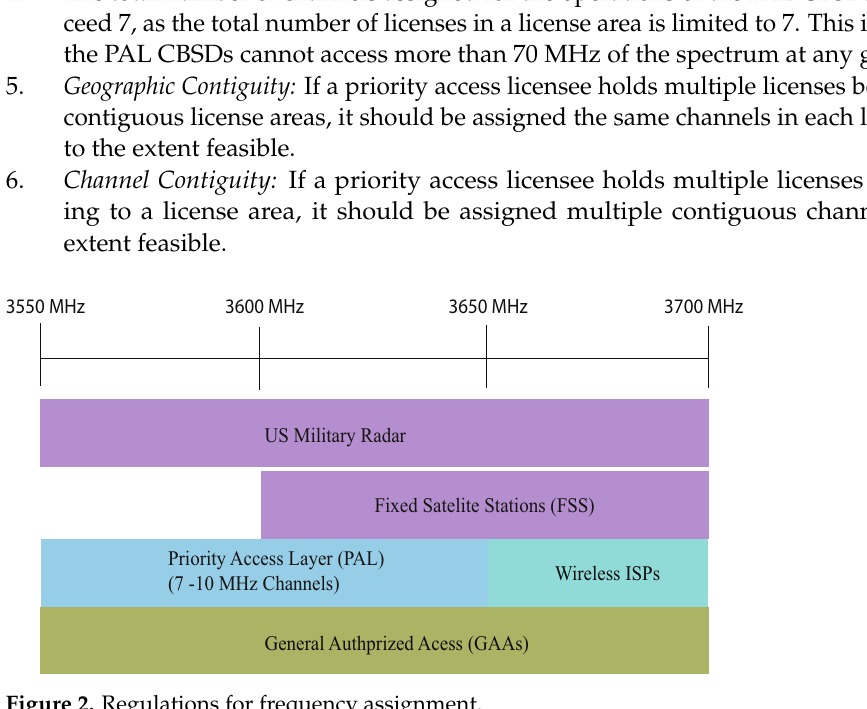
Figure 2. Regulations for frequency